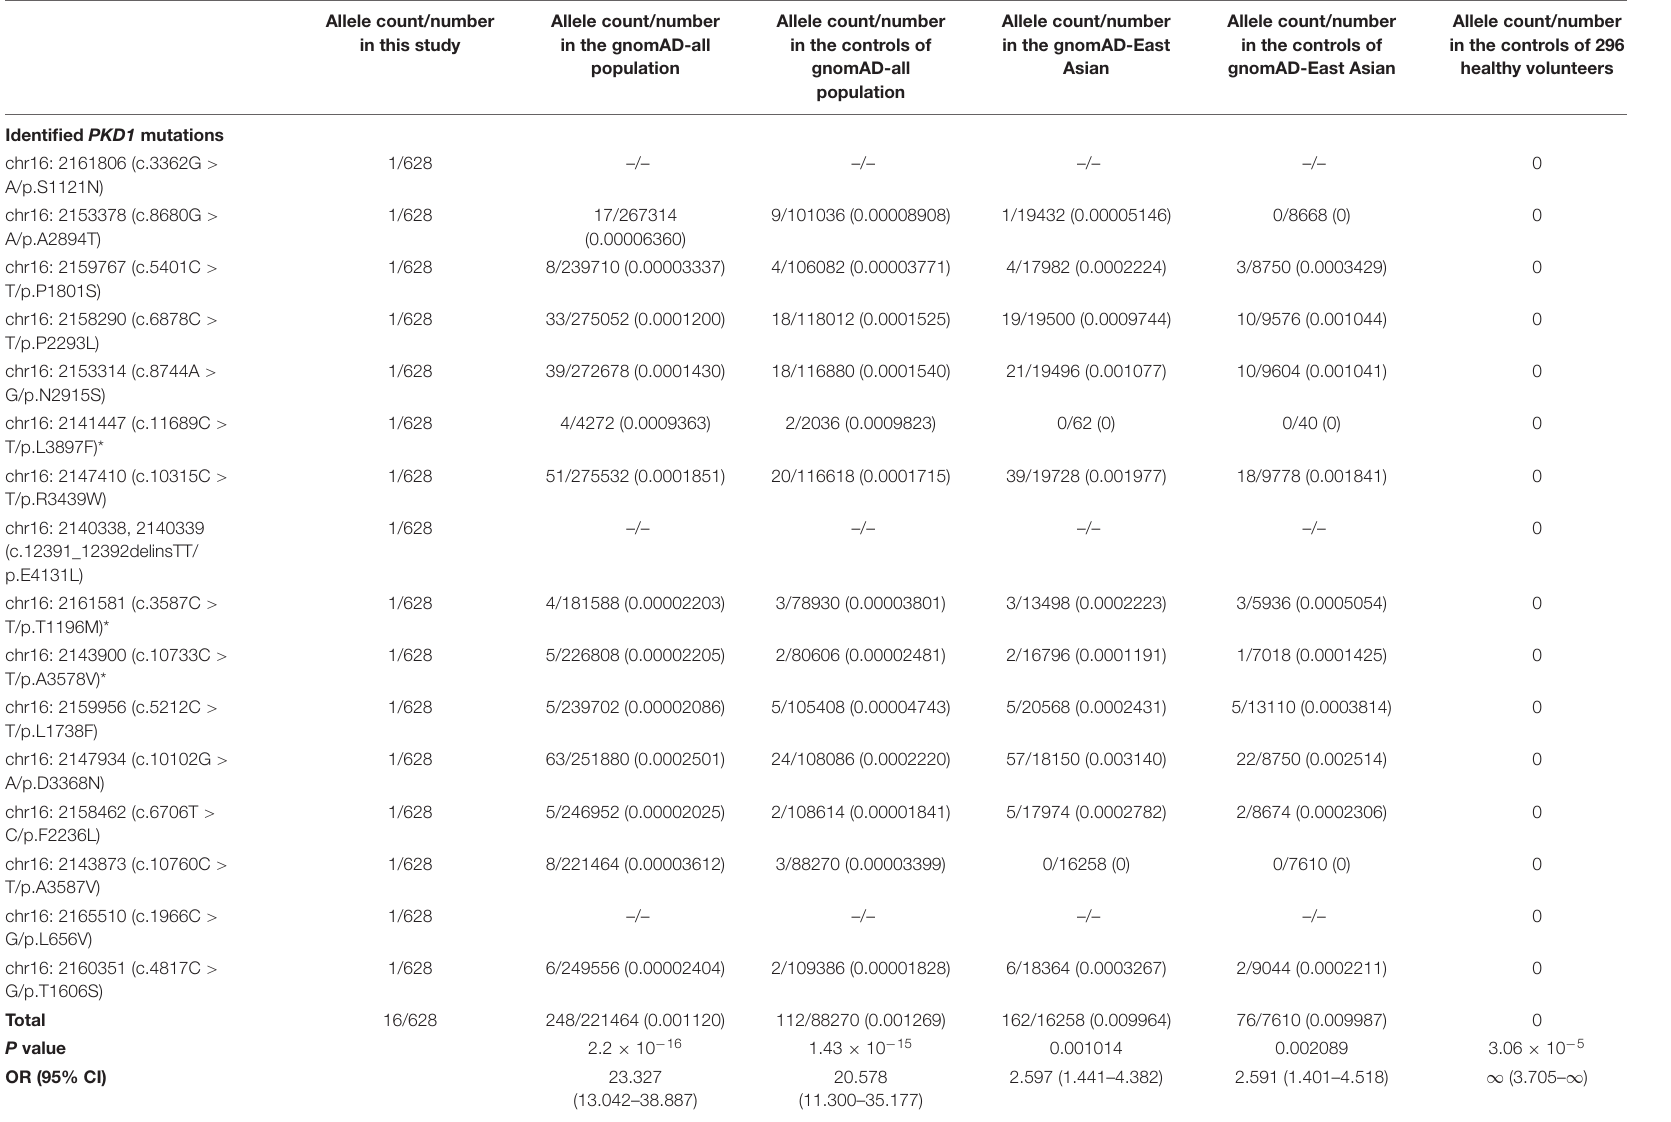
TABLE 2 | A gene-based burden analysis for PKD1 mutations identified in this study.